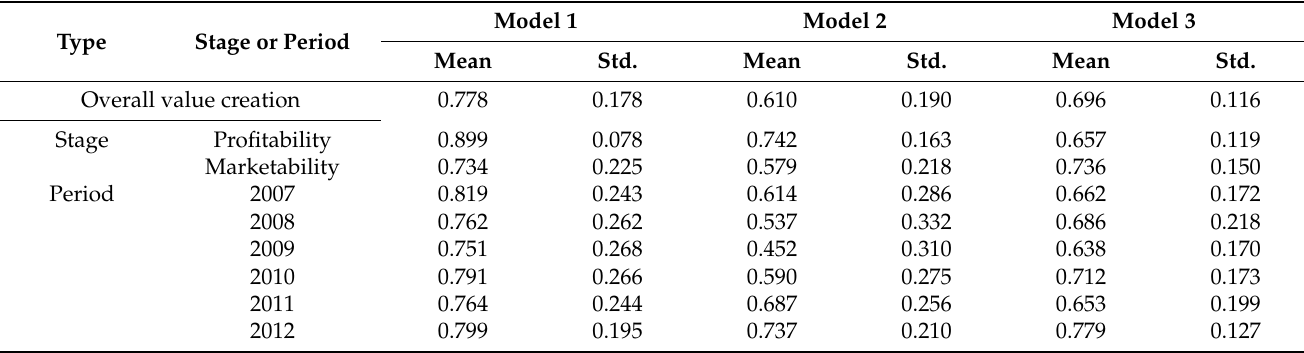
Table 5. Performance comparison of Models 1–3.